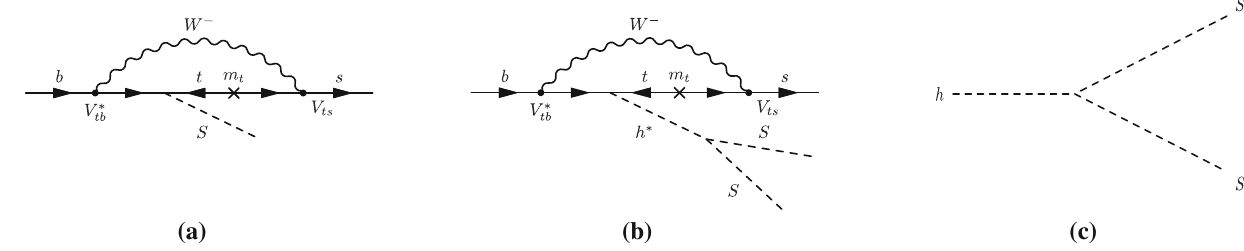
Fig. 8 Diagrams responsible for S production in a minimal extended Higgs sector. a is proportional to the mixing between S and Higgs, sin 2 θ , while b and c are proportional to the square of the quartic coupling, λ